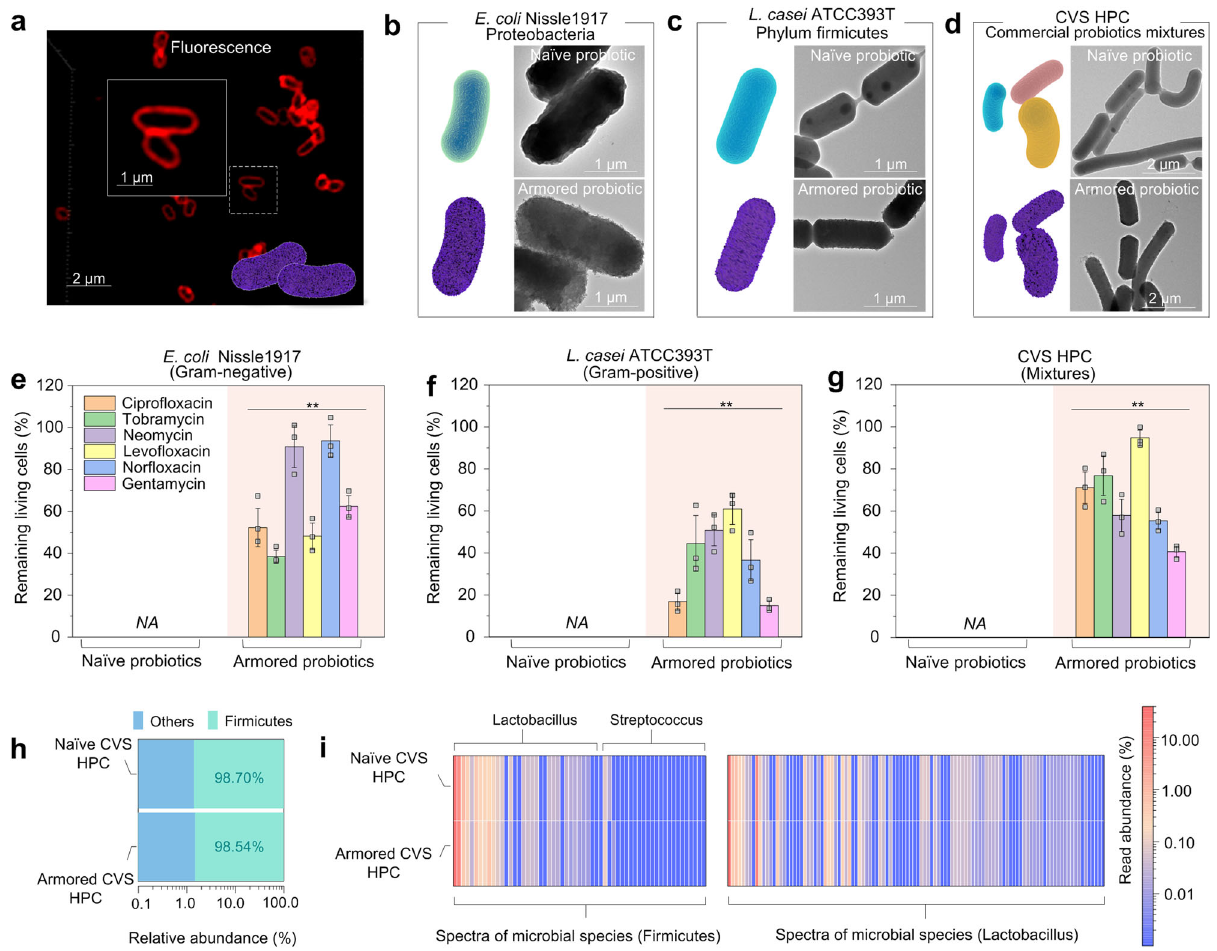
Fig. 2 Nanoarmor of bacteria and protective effect from a wide range of antibiotics. a CLSM images of armored EcN. Nanoarmor was labeled with bovine serum albumin conjugated with Alexa Fluor 647. b TEM images of naïve or armored EcN. c TEM images of naïve or armored L. casei . d TEM images of naïve or armored CVS HPC. e Relative bacterial viability of naïve or armored EcN after exposure to six different antibiotics for 24 h, NA , not detectable. Statistical comparisons were performed using two-tailed unpaired t -tests ( n = 3). For the group of cipro fl oxacin, p = 0.001267< 0.01. For the group of tobramycin, p = 0.000064< 0.001. For the group of neomycin, p = 0.000207< 0.001. For the group of levo fl oxacin, p = 0.00041 < 0.001. For the group of nor fl oxacin, p = 0.00065< 0.001. For the group of gentamicin, p = 0.000067 < 0.001. f Relative bacterial viability of naïve or armored L. casei ATCC393T after exposure to six different antibiotics for 24 h, NA , not detectable. Statistical comparisons were performed using two-tailed unpaired t -tests ( n = 3). For the group of cipro fl oxacin, p = 0.004041 < 0.01. For the group of tobramycin, p = 0.009074< 0.01. For the group of neomycin, p = 0.000618 < 0.001. For the group of levo fl oxacin, p = 0.000296 < 0.001. For the group of nor fl oxacin, p = 0.00614 < 0.01. For the group of gentamicin, p = 0.000681 < 0.001. g Relative bacterial viability of commercial blends of naïve probiotic strains CVS HPC and armored blends after exposure to six different antibiotics for 24 h, NA not detectable. Statistical comparisons were performed using two-tailed unpaired t -tests ( n = 3). For the group of cipro fl oxacin, p = 0.000178 < 0.001. For the group of tobramycin, p = 0.000305< 0.001. For the group of neomycin, p = 0.000435< 0.001. For the group of levo fl oxacin, p = 0.000003 < 0.001. For the group of nor fl oxacin, p = 0.000041 < 0.01. For the group of gentamicin, p = 0.000024 < 0.001. h Taxa summary map of different phyla in naïve or armored CVS HPC. i Heatmap of metagenomic sequencing results of different Fimicutes strains of naïve or armored CVS HPC. * p -value < 0.05; ** p -value < 0.01; *** p -value < 0.001. The graphs represent mean values ± standard error of mean for Fig. 2e-g. Signi fi cant differences between mean values were evaluated using ANOVA with multiple curves (Fig. 4b, c). Although natural polyphenols generally pos- sess antibacterial capacity, the formation of nanostructured net- works around the cells (Supplementary Figs. S4 and S10) show a neglected effect on the bacteria probably due to the formation of supramolecular nanocomplexes based on metal-phenolic coor- dination (Supplementary Fig. S12) 54 . The protection offered by the nanoarmor is inherently transient since bacteria become susceptible to the antibiotic again after cell division since it ensures that the bacteria essentially return to their original state on a relatively fi xed timescale. We con fi rmed the feasibility of the double encapsulation scheme with a simple in vitro model that mimicked GI transit. Lyophilized EcN (armored and naïve) were